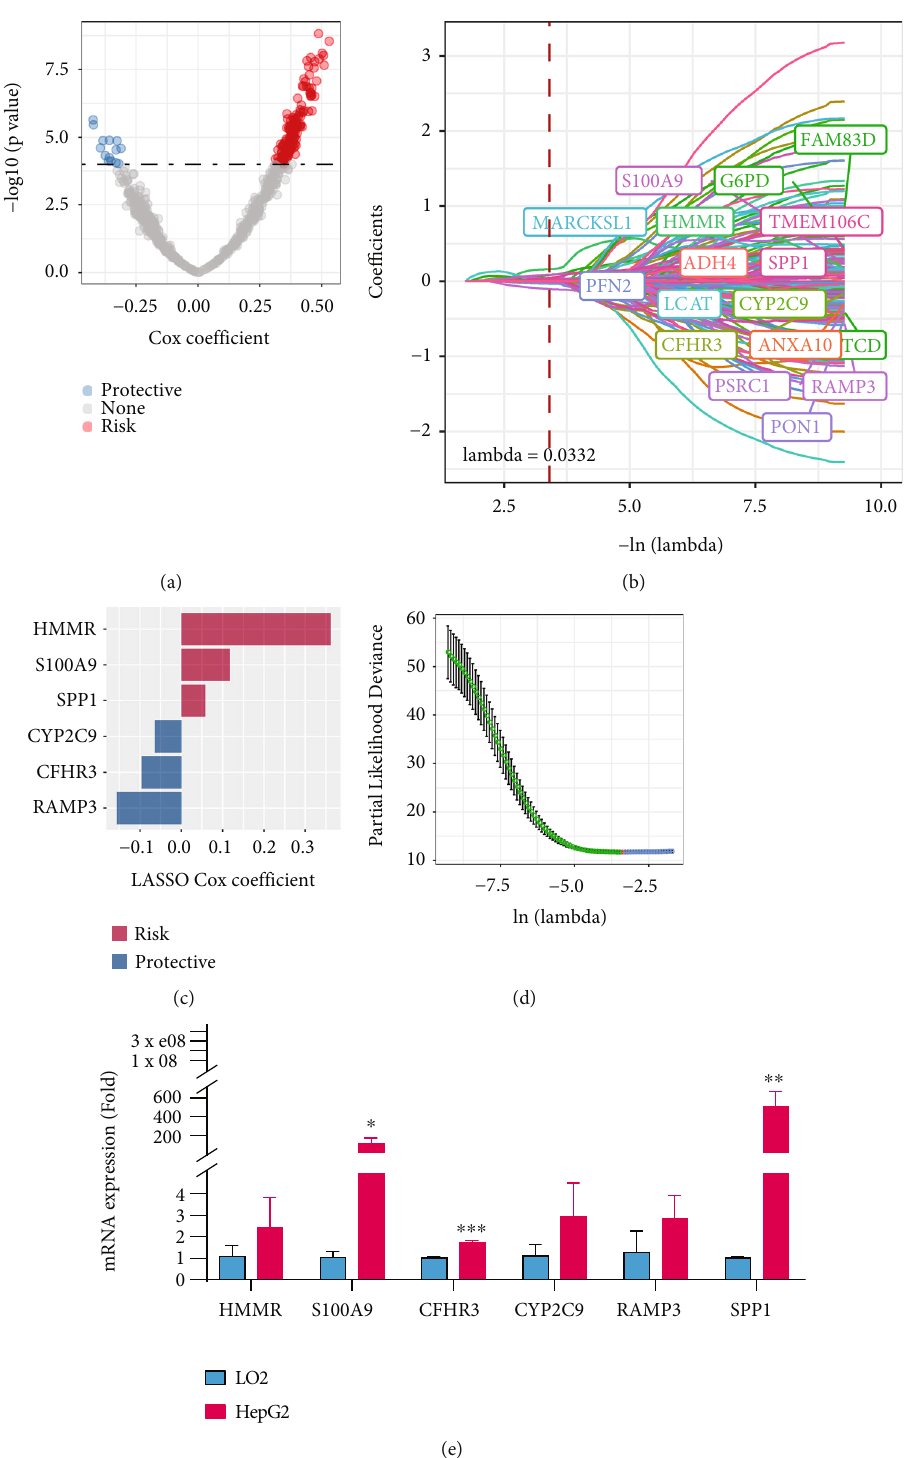
Figure 4: Construction of aging-associated gene-based prognostic model. (a) Di ff erently expressed genes among the three clusters. In total, 139 genes were selected. The red represents risk factor genes, and the blue represents protective roles. (b) The curve of coe ffi cients changes with the value of lambda. (c) The partial likelihood deviance varies with the value of lambda. (d) Distribution of LASSO coe ffi cients of the senescence-related gene signature. (e) mRNA expression of six senescence-related genes. *P < 0.05; **P < 0.01; ***P < vated mast cells (Figure 6(a)). The ESTIMATE analysis revealed that the high CSRS group had signi fi cant lower estimated proportions in stromal score (Figure 6(b)).